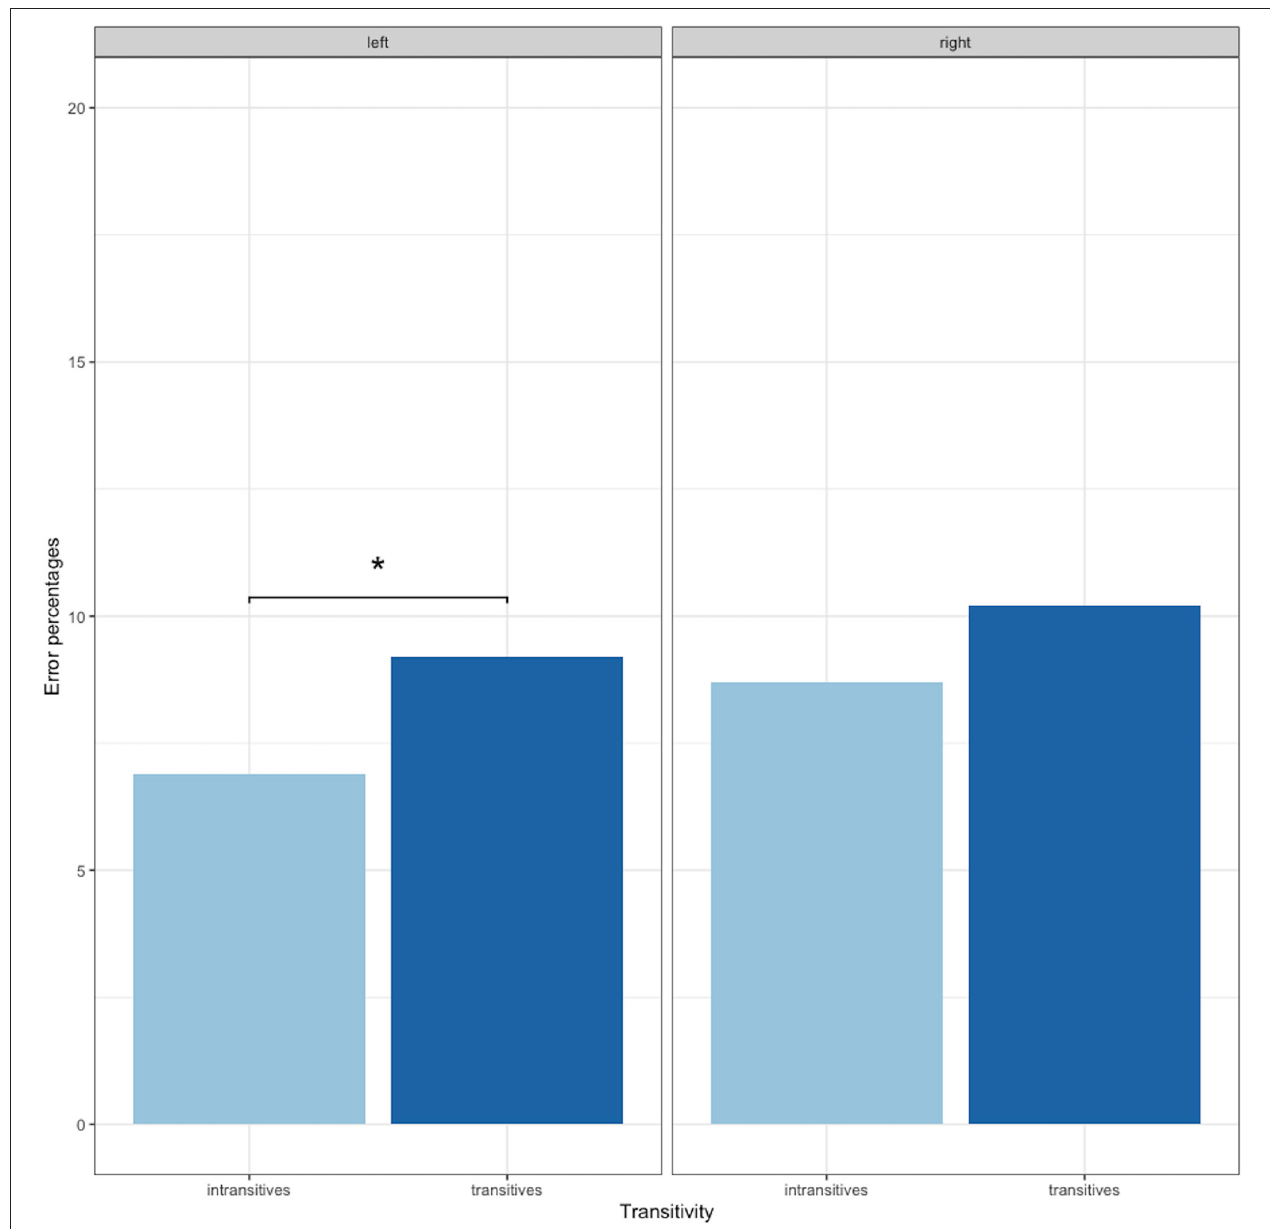
FIGURE 3 | Error percentages of nTMS induced errors according to verb type and hemisphere. The axis has been set to 20% for purposes of visualization. * p <